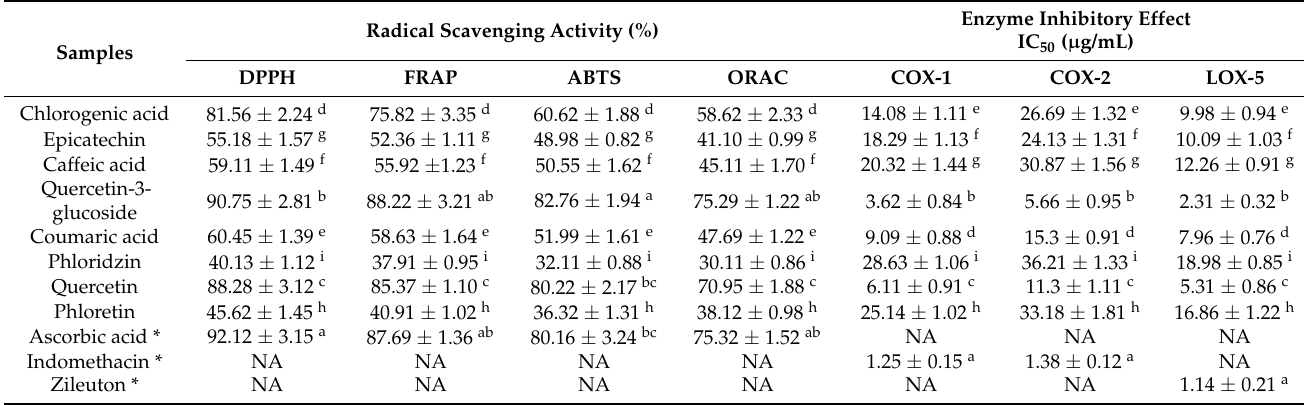
Table 2. In Vitro Antioxidant and Anti-Inflammatory Activity of Apple Pomace Polyphenolics.